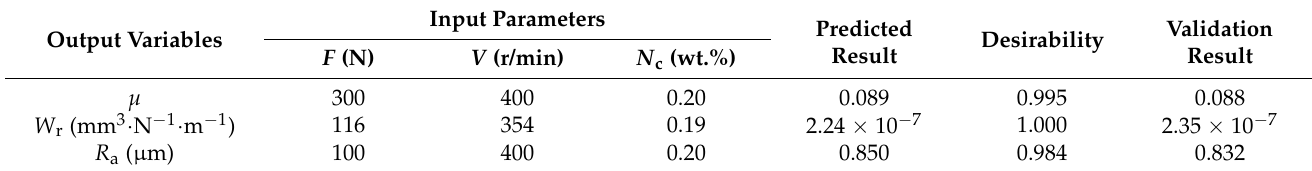
Table 9. The predicted and validation results.